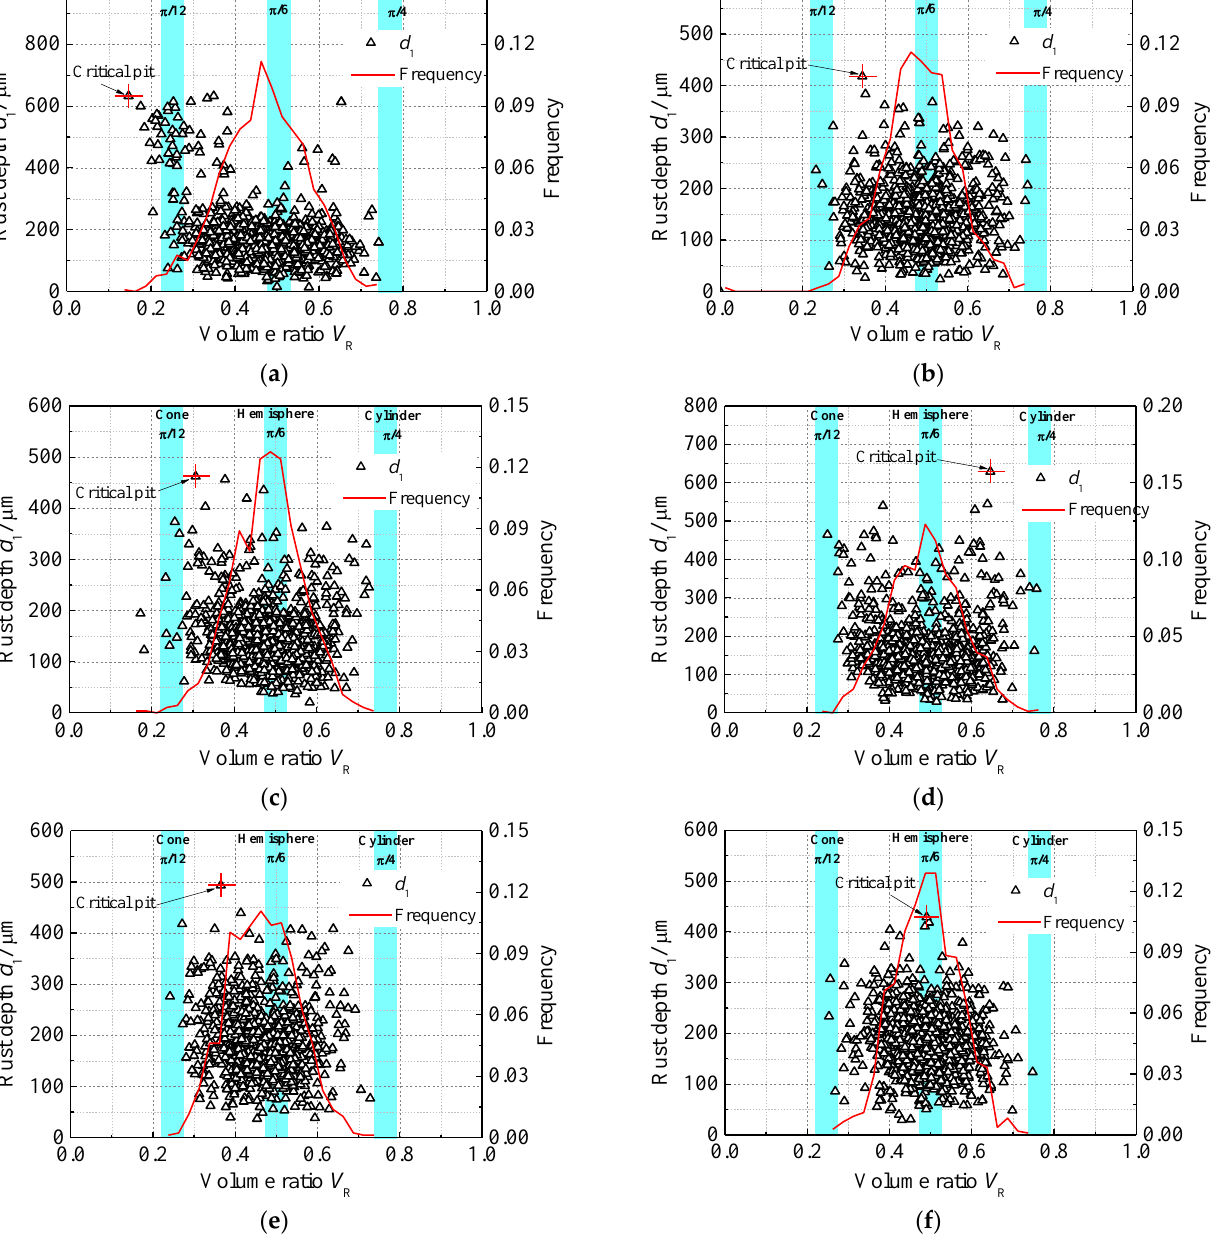
Figure 10. Rust pit depth d 1 versus volume ratio V R , as well as the frequency distribution of V R , for corroded steel plates with different corrosion durations: ( a ) C3, ( b ) C4, ( c ) C6, ( d ) C8, ( e ) C12, ( f ) C15.